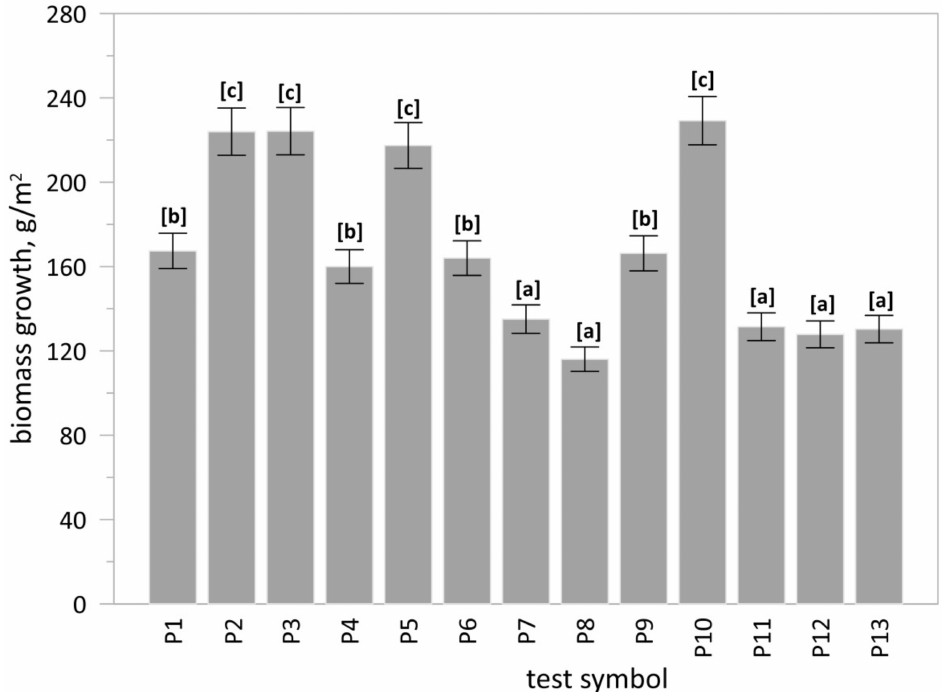
Figure 8. Plant biomass growth in pot cultivation. Explanation: bar–mean value, whiskers–standard deviation (n = 3); test symbol according to Table 12; different letters [a, b, c] indicate significant differences among groups (substrates) according to the Tukey’s HSD test.